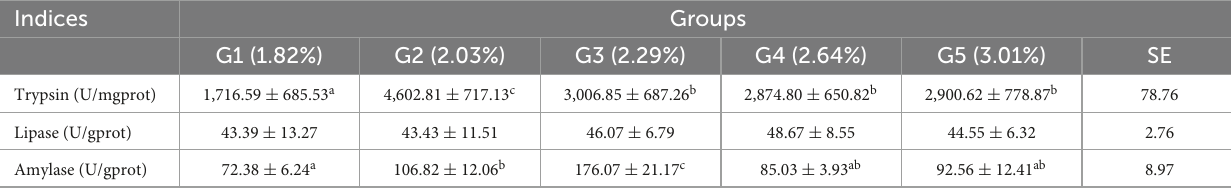
TABLE 9 Effects of dietary phenylalanine levels on the digestive enzyme of triploid O. mykiss .